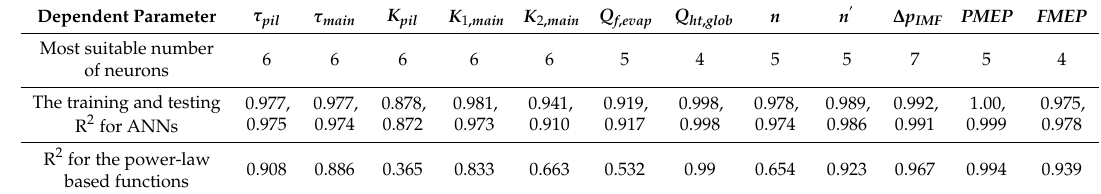
Table 8. Comparison of the correlation coe ffi cient of the ANNs and of the power-law empirical functions that estimate the tuning parameters of the physics-based model.